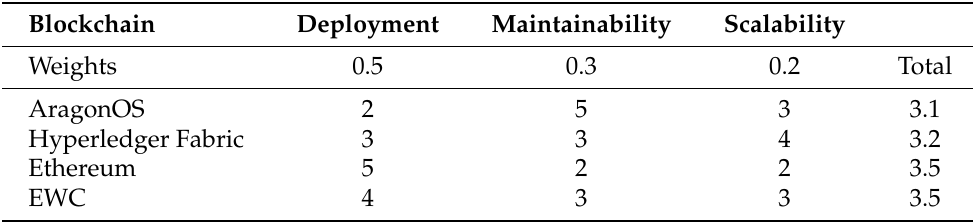
Table 2. Assessment comparison of various blockchain frameworks.